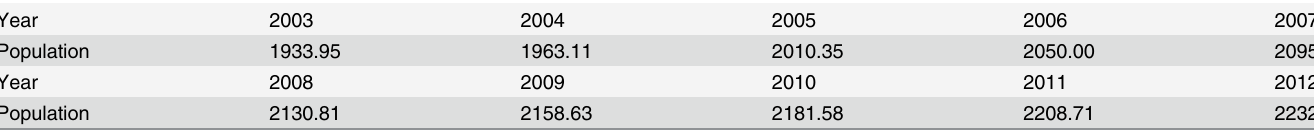
Table 3. The demographic data from 2004 to 2012 for Xinjiang(unit: ten thousand).